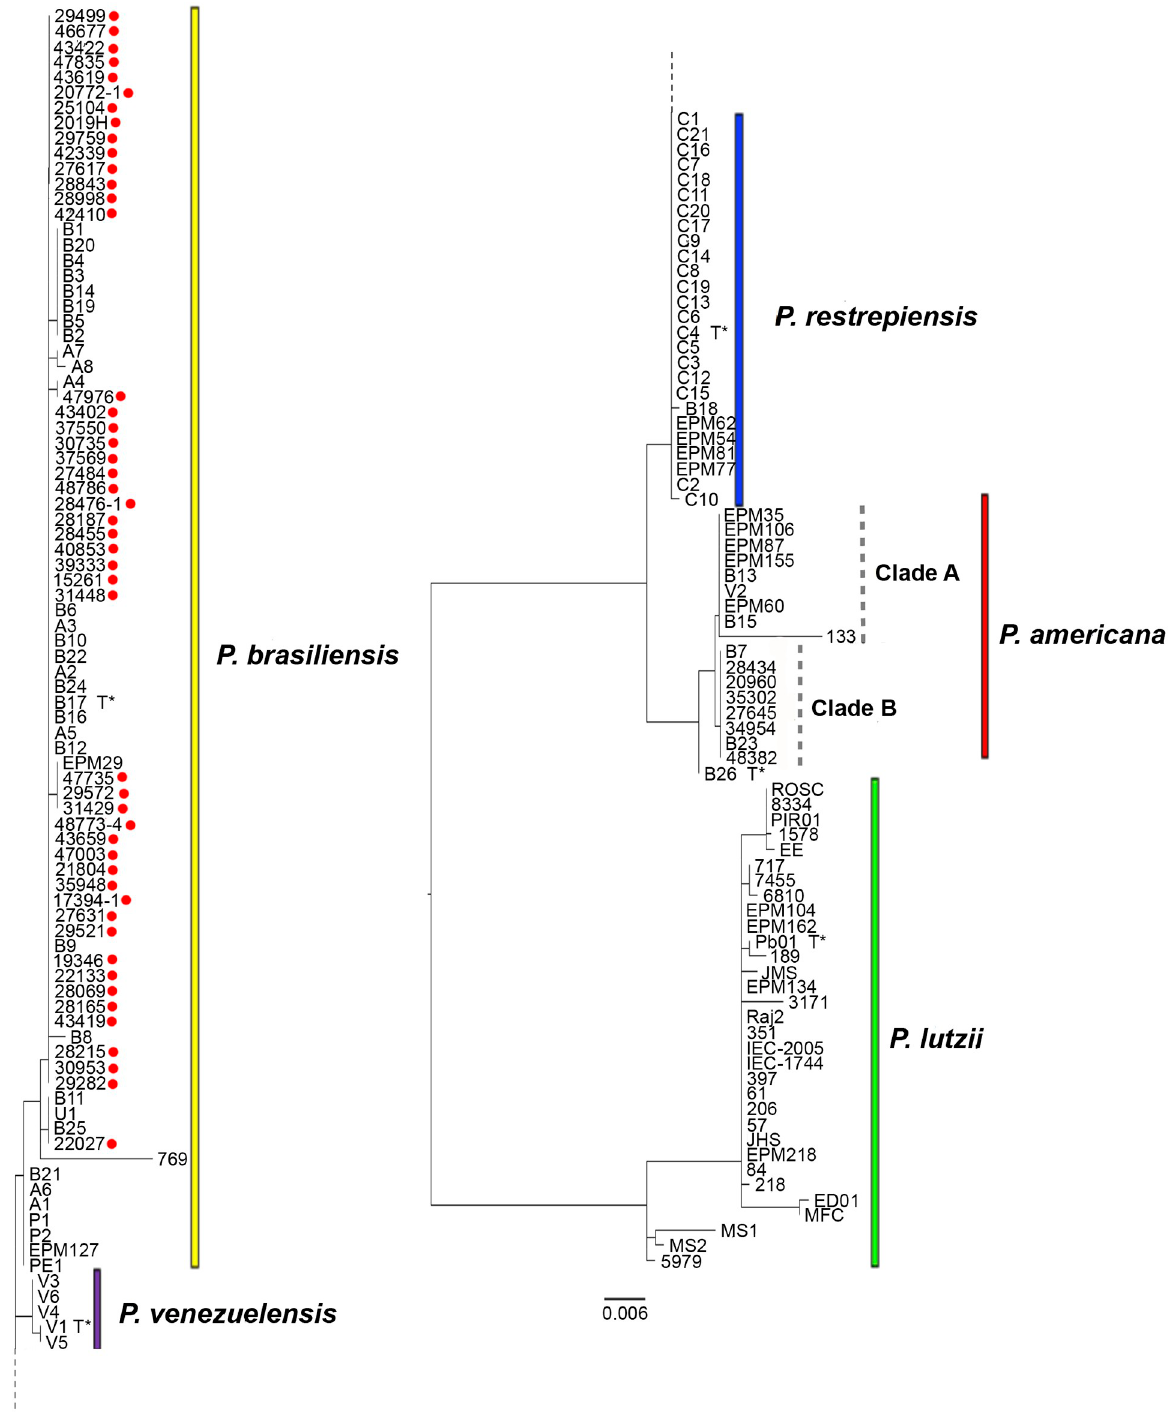
Fig 2. Phylogenetic tree including the strains identified in this study and reference strains. The relationships of arf and gp43 genes among the 54 clinical isolates included in this study (marked with red dots) and 110 strains previously identified are represented. Type strains for each species are marked with T � . The phylogenetic tree was estimated in the FigTree version 1.4 software. Colors in bars represent the Paracoccidioides species described so far. Yellow: P . brasiliensis , red: P . americana , blue: P . restrepiensis , purple: P . venezuelensis , green: P . lutzii . Clades A and B of P . americana are also represented (gray dotted vertical